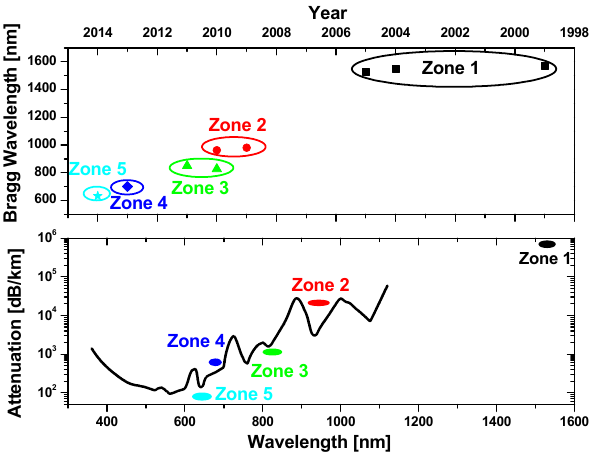
Figure 1. Historical evolution of the operating wavelength of PMMA POF Bragg grating since 1999 as well as the typical attenuation spectrum of PMMA POF.